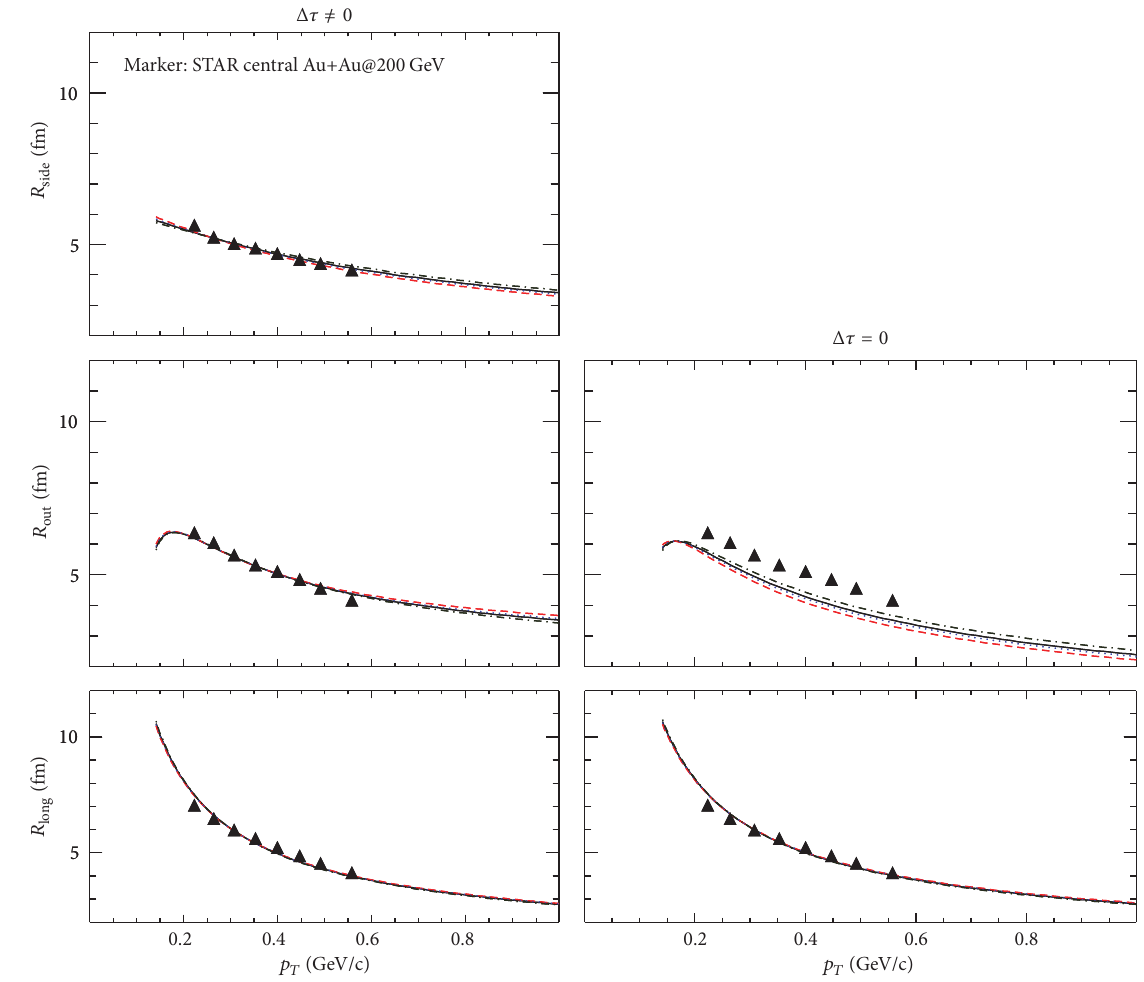
= 200 GeV. Markers are experimental NN